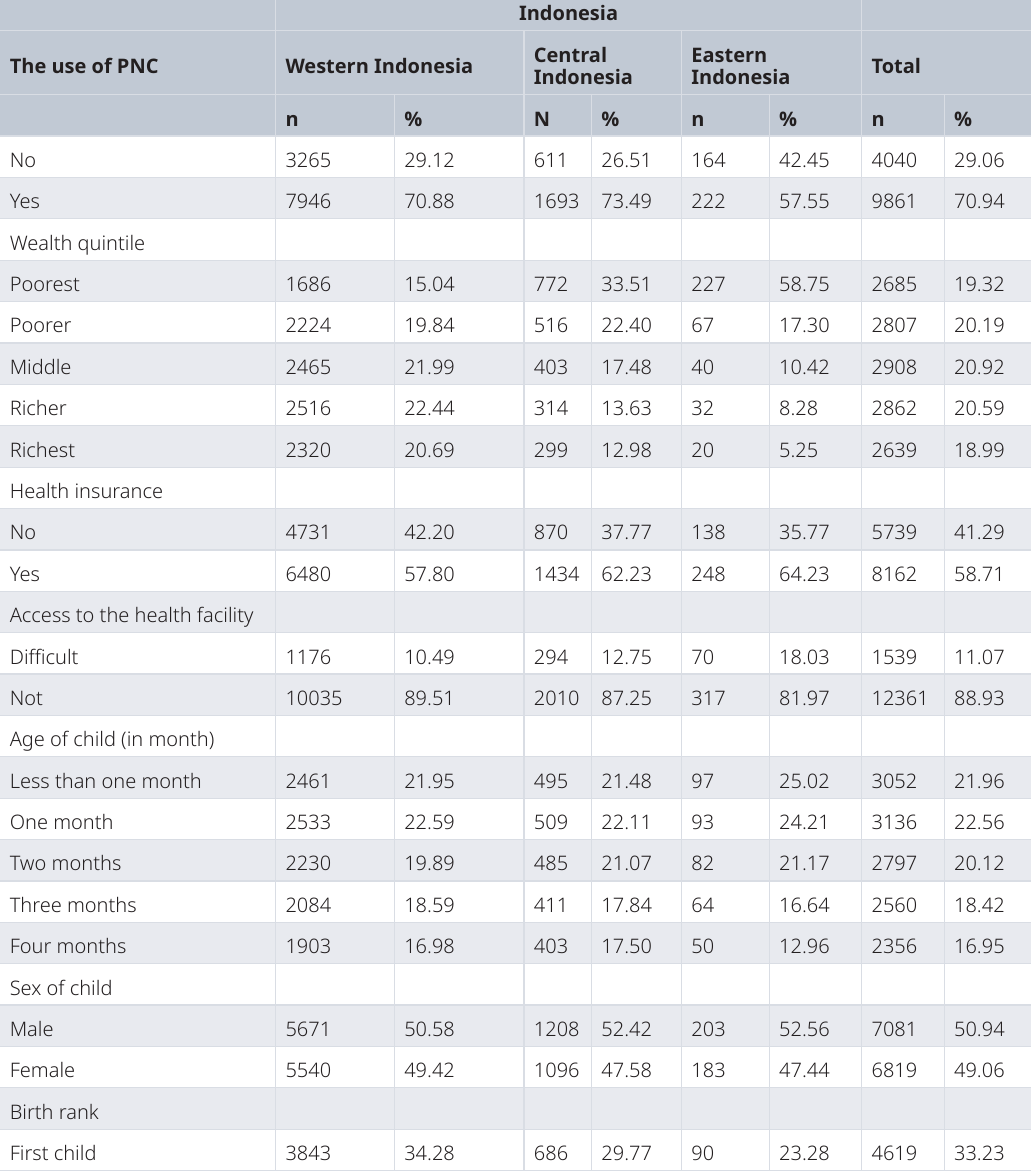
Table 2. Socio-demographic characteristic of study participants PNC in Indonesia based on region